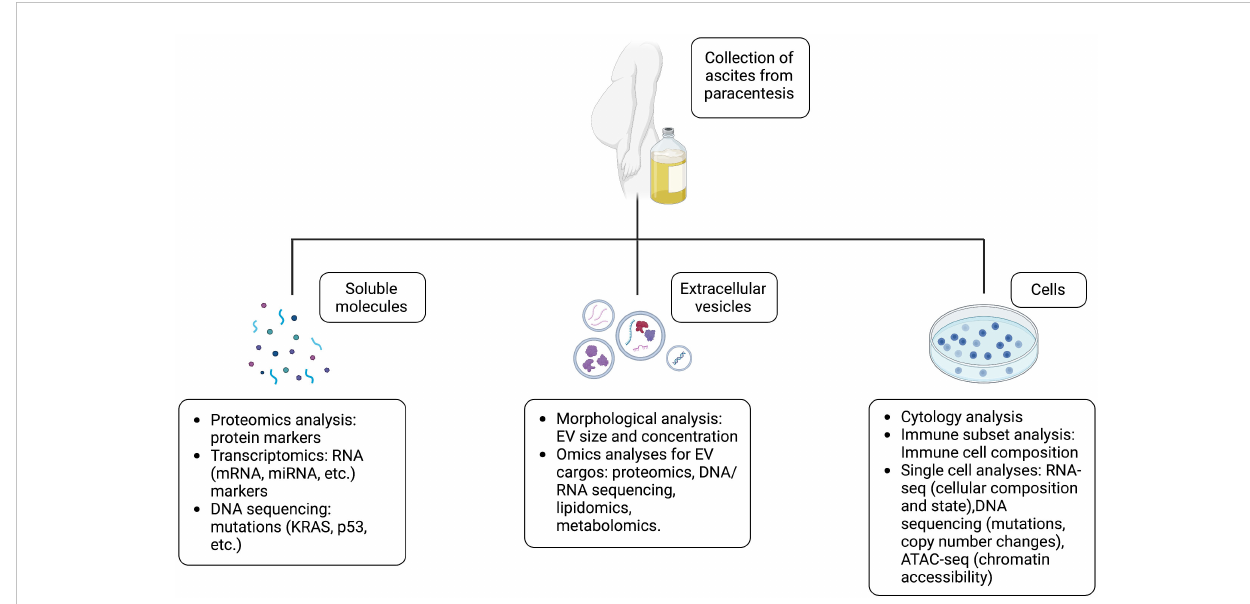
FIGURE 1 Molecular characterization of malignant ascites in